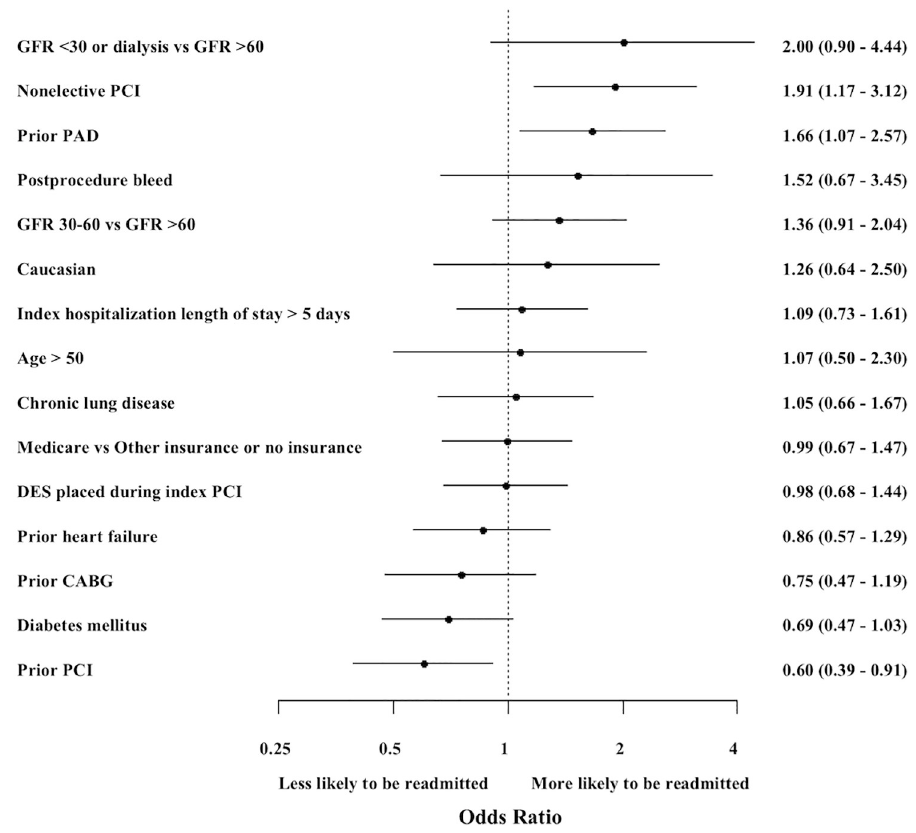
Fig 1. Predictors of readmission among patients discharged on oral anticoagulant (OAC) therapy. CABG, coronary artery bypass graft surgery; DES, drug eluting stent; GFR, glomerular filtration rate (mL/minute); LOS, length of stay; OAC, oral anticoagulant; PAD, peripheral arterial disease; PCI, percutaneous coronary intervention.